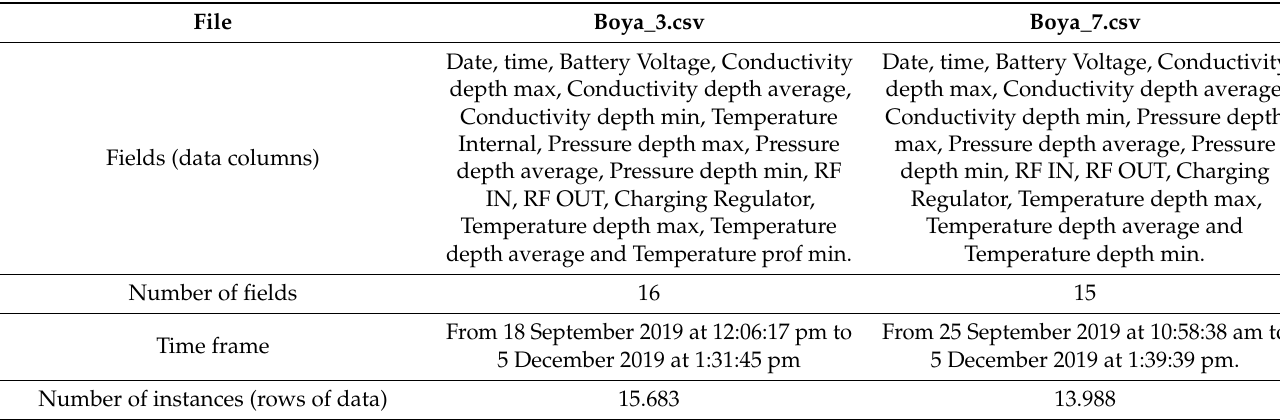
Table 3. File structures from